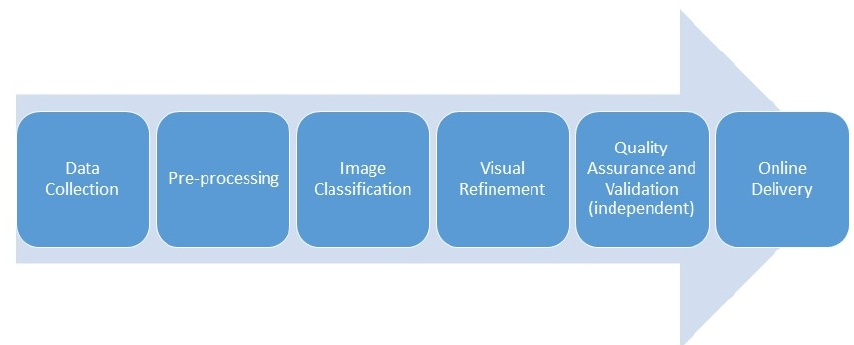
Figure 2. Overall production